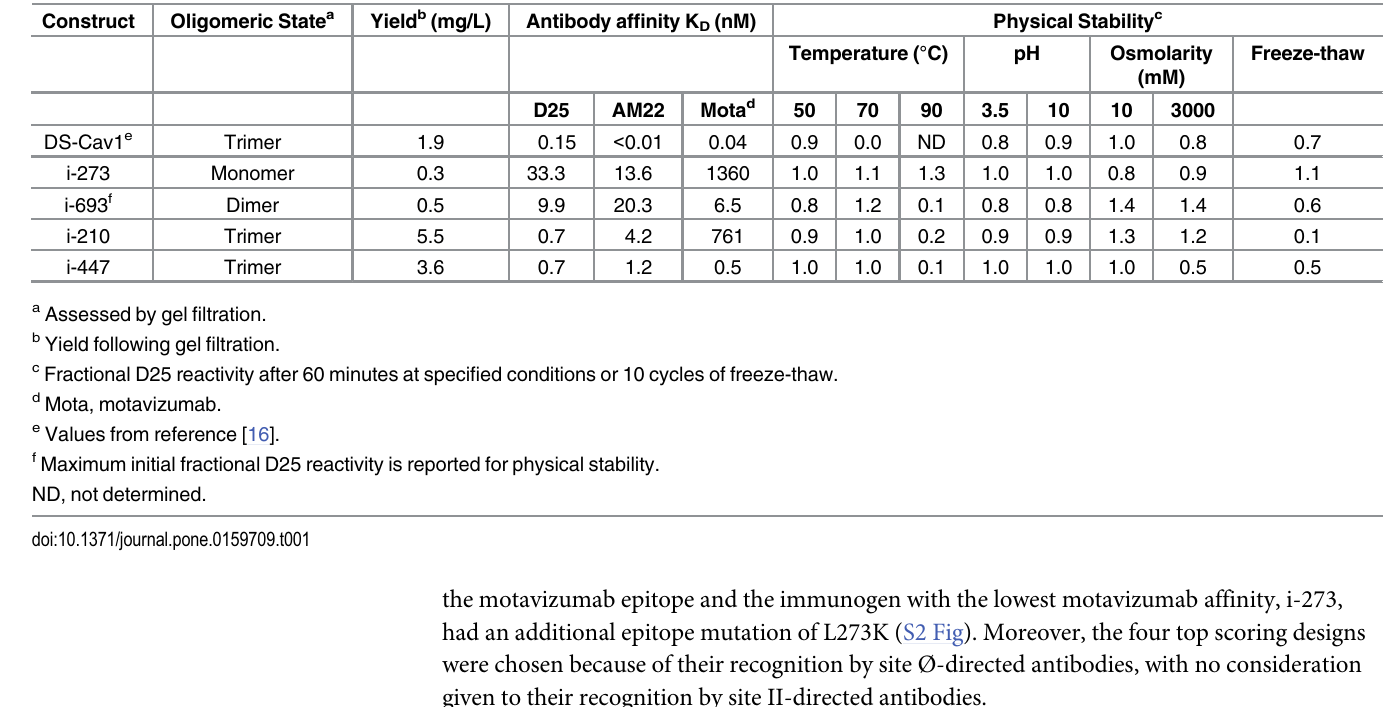
the motavizumab epitope and the immunogen with the lowest motavizumab affinity, i-273, had an additional epitope mutation of L273K (S2 Fig). Moreover, the four top scoring designs were chosen because of their recognition by site Ø-directed antibodies, with no consideration given to their recognition by site II-directed antibodies.